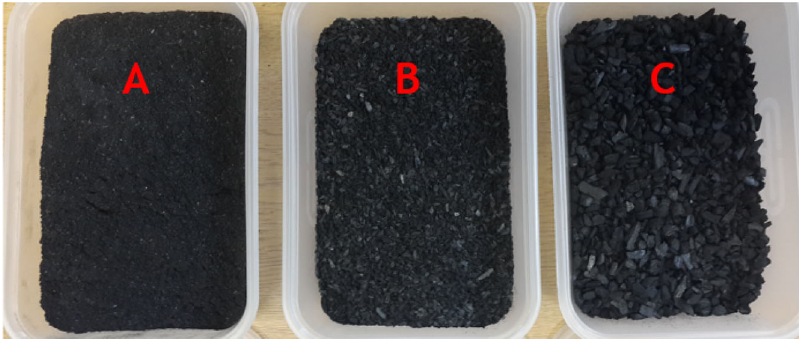
Fig. 4 The charcoal in three different sizes